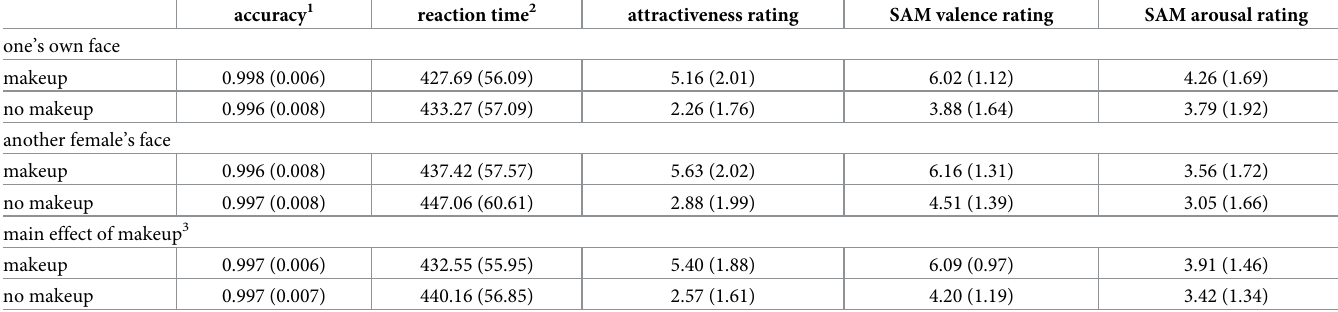
Table 2. Descriptive statistics for behavioral measures in Experiment